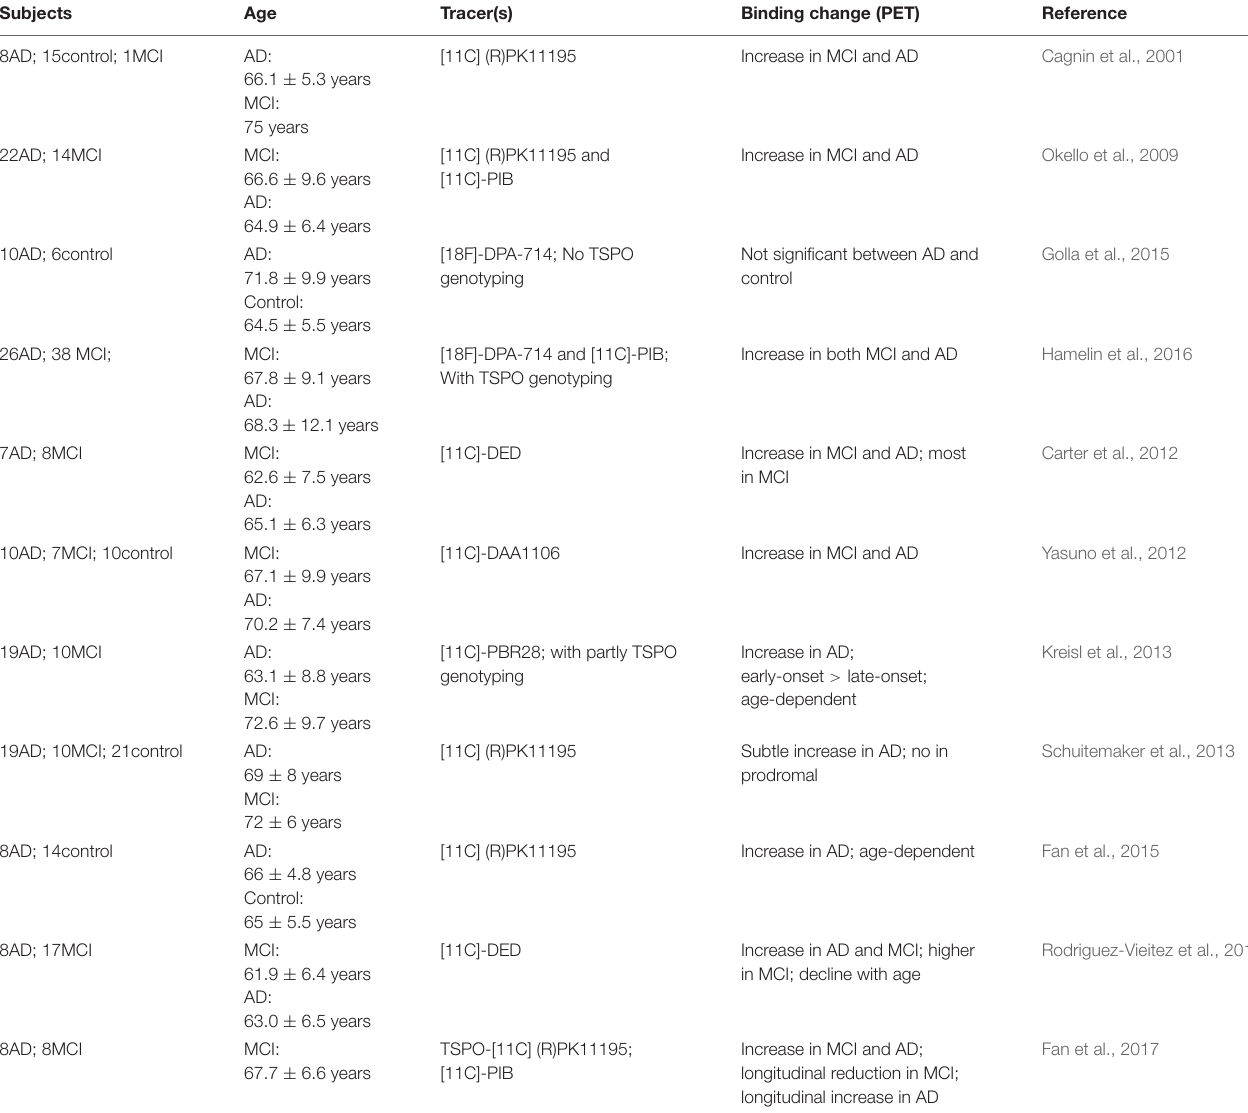
TABLE 1 | Clinical studies of microglial activation by PET imaging in AD patients. Subjects Age Tracer(s) Binding change (PET) Reference